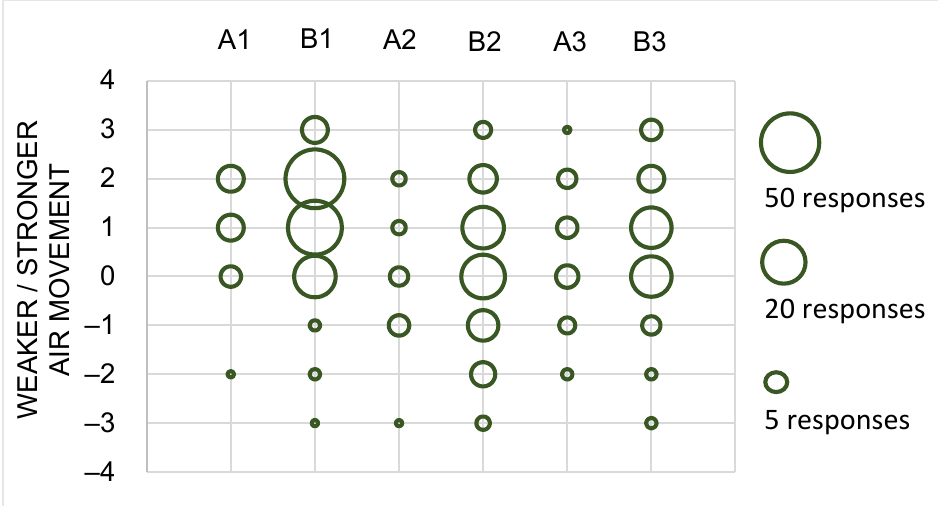
Figure 8. Air Movement Preference Votes (AmPV) from all 323 surveys.